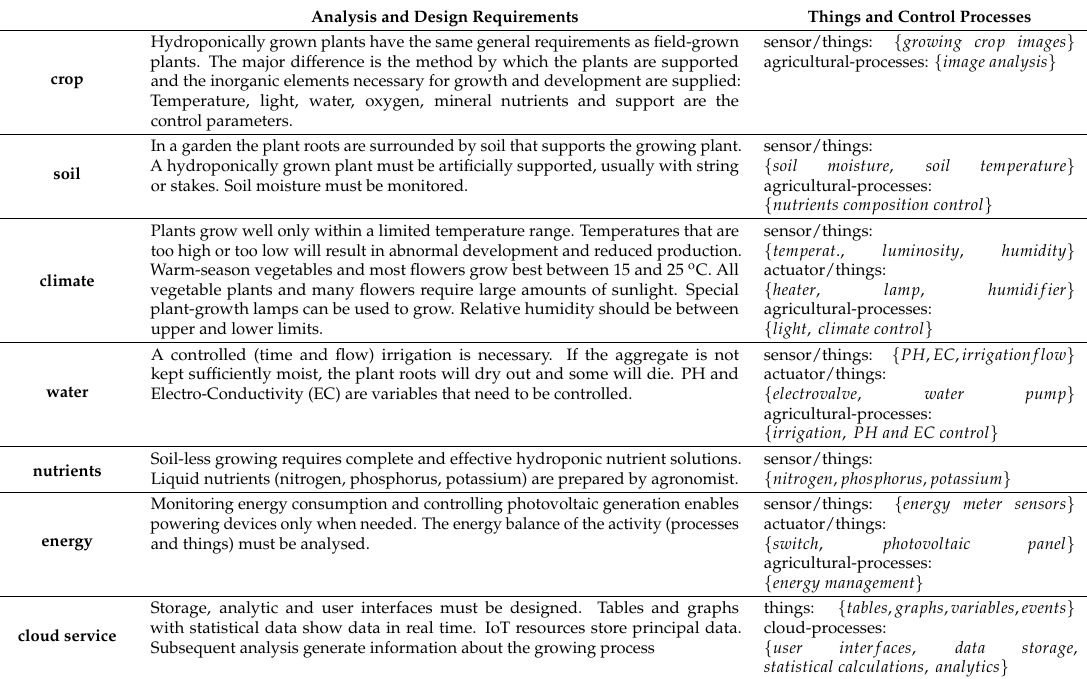
Table 2. Analysis and design requirements in experimental hydroponic